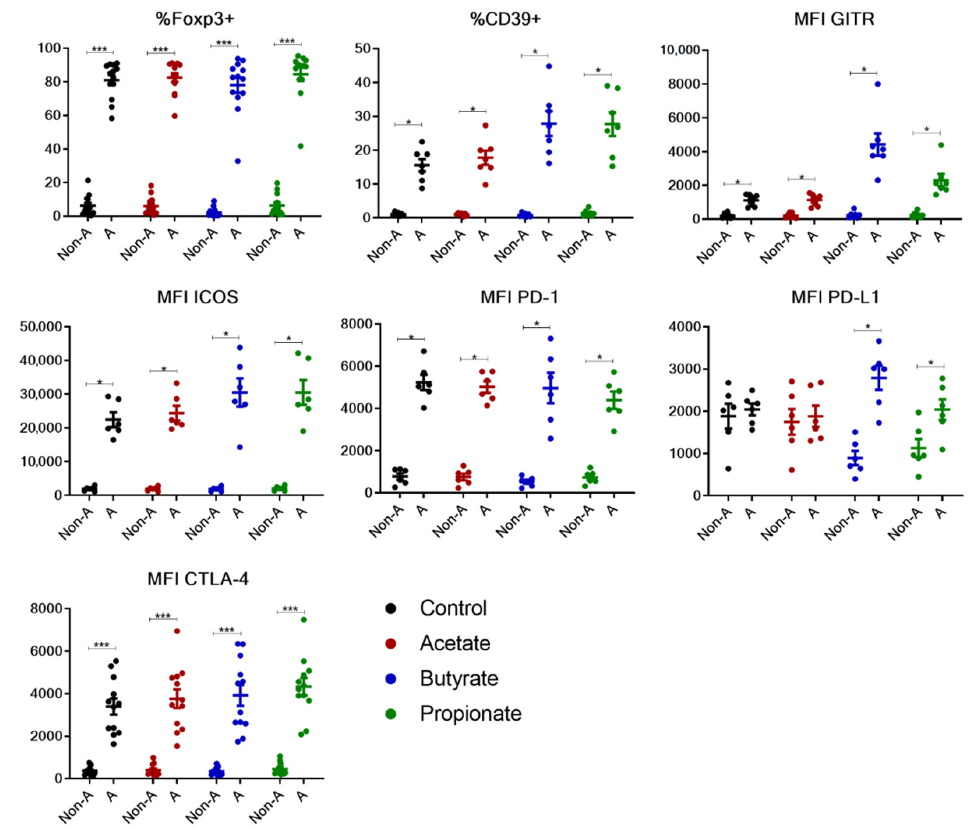
Figure 3. Enhanced expression of phenotypic markers in activated cells generated from adult naïve CD4 + cells. Scattered dot plot with mean + SEM showing the percentage of Foxp3 + and CD39 + cells, and mean fluorescence intensity (MFI) of GITR, ICOS, PD-1, PD-L1, and CTLA-4 gated on non-activated (Non-A) and activated (A) cells generated from adult naïve CD4 + cells under various conditions. All cells were cultured in the presence of transforming growth factor β and interleukin-2, and additionally with control, acetate, butyrate, or propionate. Data summarize thirteen independent experiments. Wilcoxon matched-pairs rank test was used for statistical analysis. * p < 0.05, *** p < 0.001.